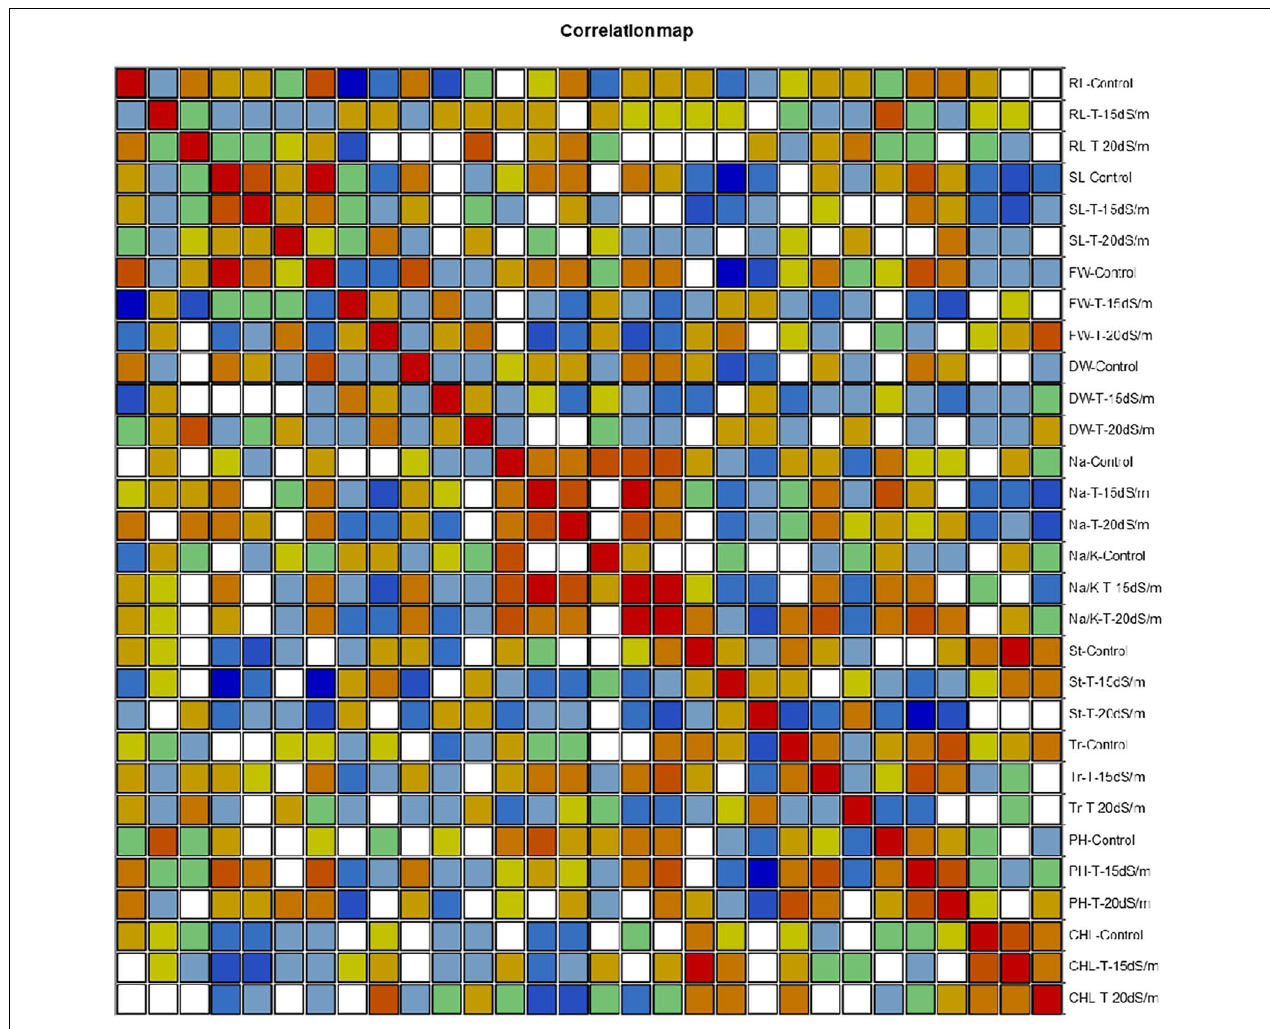
FIGURE 7 | Correlation matrix showing Pearson’s correlation among morphophysiological traits in cotton genotypes under control and salt stress conditions. RL, root length; SL, shoot length; FW, fresh weight; DR, dry weight; Na, sodium content; Na/K, sodium to potassium ratio; St, stomatal conductance; Tr, transpiration rate; PH, photosynthetic rate; CHL, chlorophyll